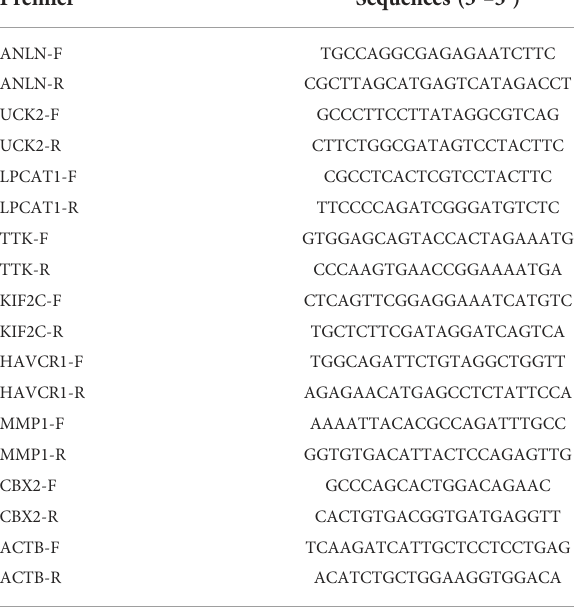
TABLE 2 Premier sequences for qRT-PCR